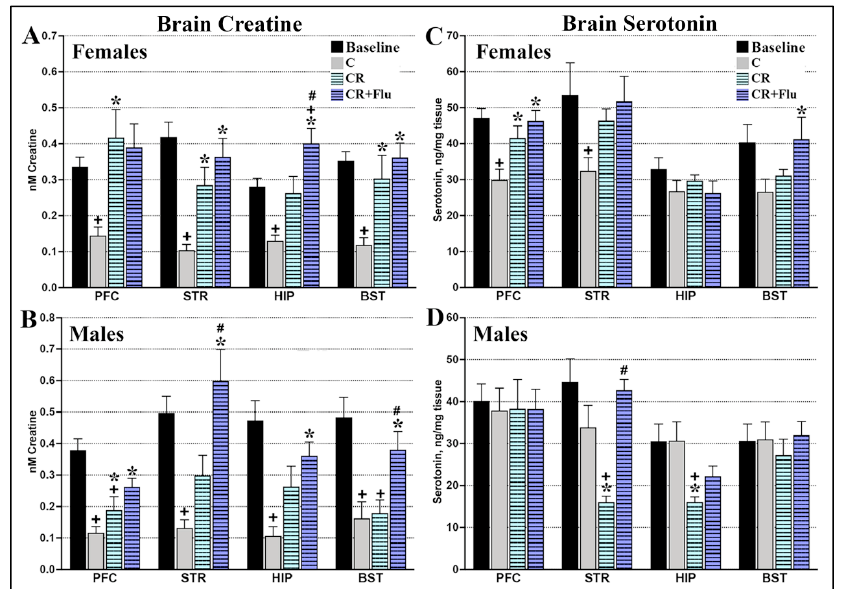
Figure 9. Dietary CRMH combined with SSRI alters brain creatine and serotonin vs. dietary CRMH alone. (1) Brain creatine: ( A ). in females at altitude, CRMH + FLU increased brain creatine vs. controls in all 4 brain regions but did not change regional brain creatine vs. dietary CRMH alone, except in the HIP. ( B ). In males, CRMH + FLU also increased brain creatine levels vs. controls in all 4 regions. CRMH + FLU also increased striatal brain creatine levels vs. dietary CRMH alone, to resolve the deficit in brain creatine seen after 5 weeks at altitude. (2) Brain serotonin: ( C ). in female rats at altitude, CRMH + FLU significantly increased serotonin in the PFC, STR and BST vs. food controls, but did not alter regional serotonin in any region vs. dietary CRMH alone. The female HIP was unchanged with treatment. ( D ). In males, CRMH + FLU improved serotonin in the STR vs. dietary CRMH alone but did not significantly alter serotonin levels in the other 3 regions. One-way ANOVA, * = p <0.05 vs. food controls, # = p < 0.05 vs. dietary CR, + = p < 0.05 vs. 1 week altitude or baseline).